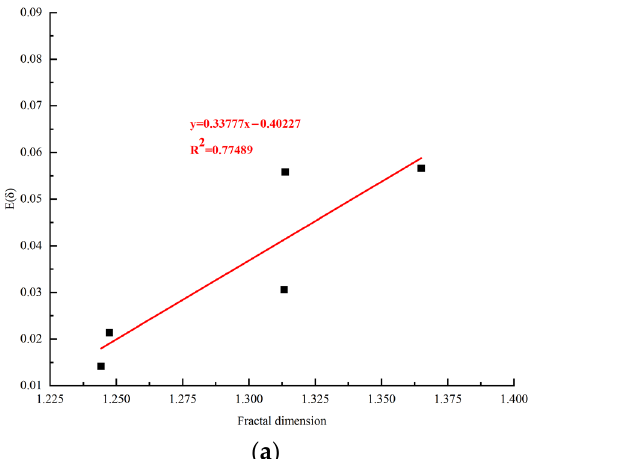
Figure 12. Relationship between fractal dimension and average increment of the cumulative pile top displacement between each cycle step after the first cyclic loading. ( a ) Peak value of cyclic load: 3 N. ( b ) Peak value of cyclic load: 4 N.